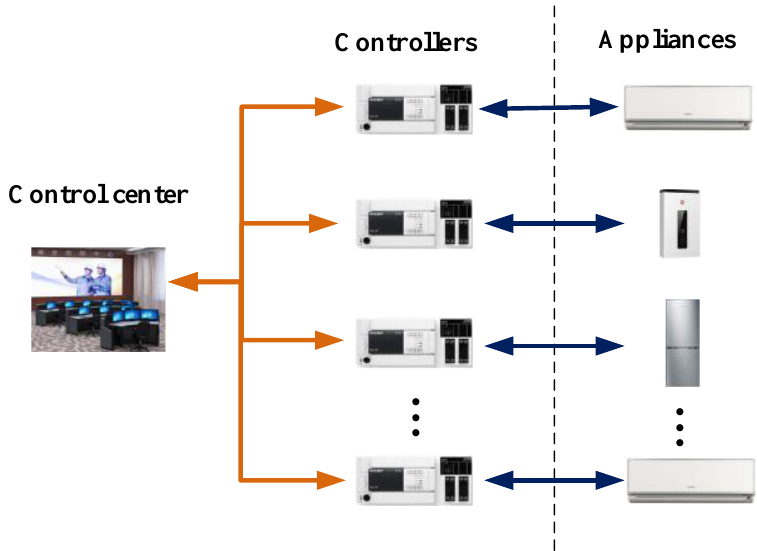
Figure 2. The structure of the hybrid hierarchical DR control.